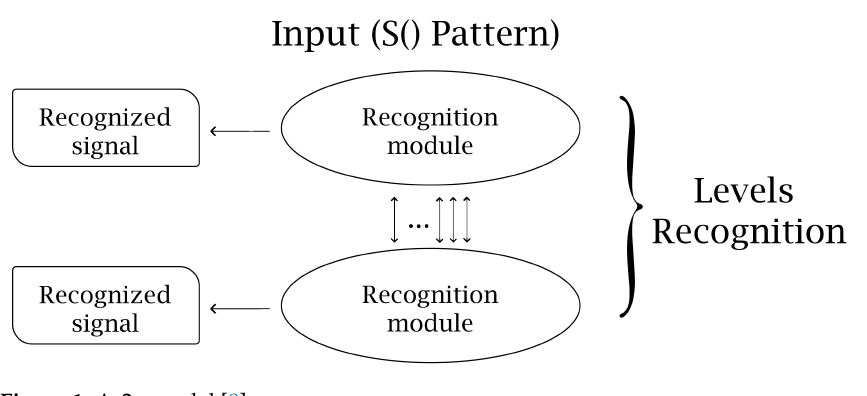
Figure 1. Ar2p model [8].